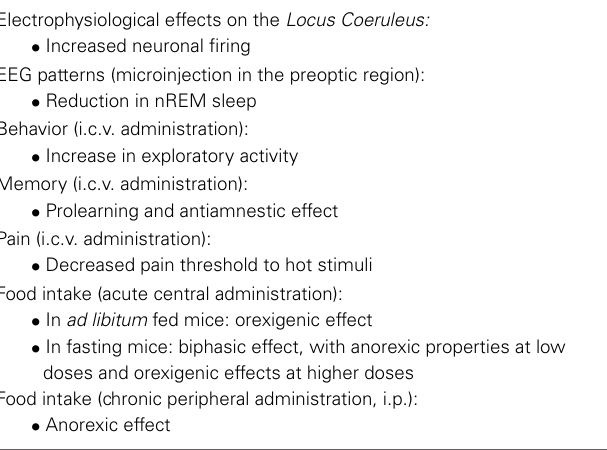
Table 2 | Neurological effects of